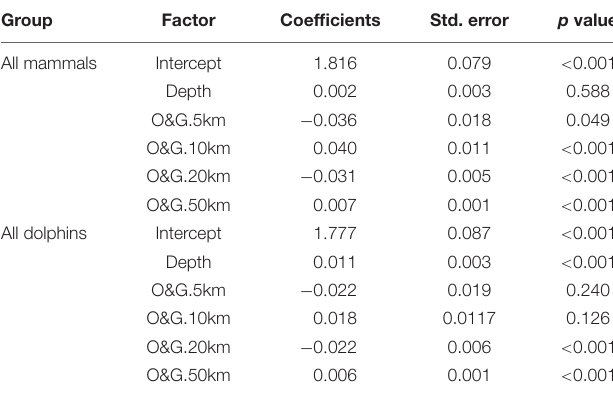
TABLE 4 | Coefficients of the best supported model for the relation between all mammals and all dolphins group size and depth and number of oil and gas facilities within 5, 10, 20, and 50 km